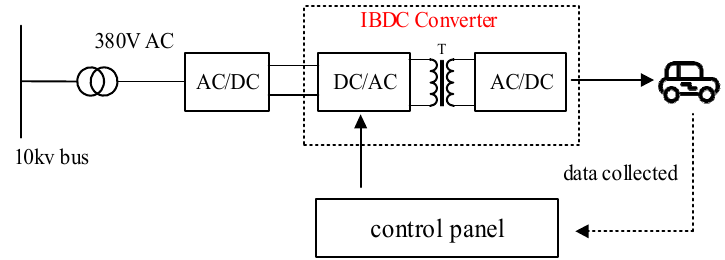
Figure 2. Electric vehicle charging structure diagram.